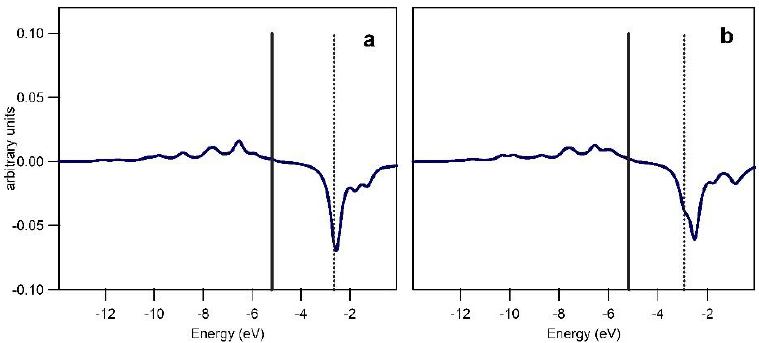
Figure 4. COOPs for the PdC–N interaction in TS14 ( a ) and TS6 ( b ). Solid and dotted vertical lines correspond to the HOMO and LUMO, respectively.